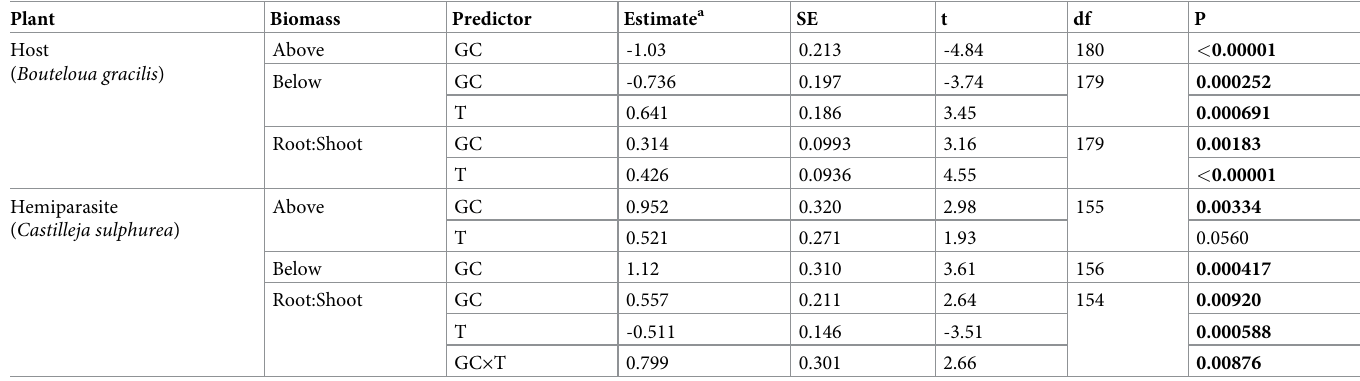
Table 1. Best-fitting linear models for aboveground biomass, belowground biomass, and the ratio of belowground to aboveground (root:shoot) biomass of the host and hemiparasite.